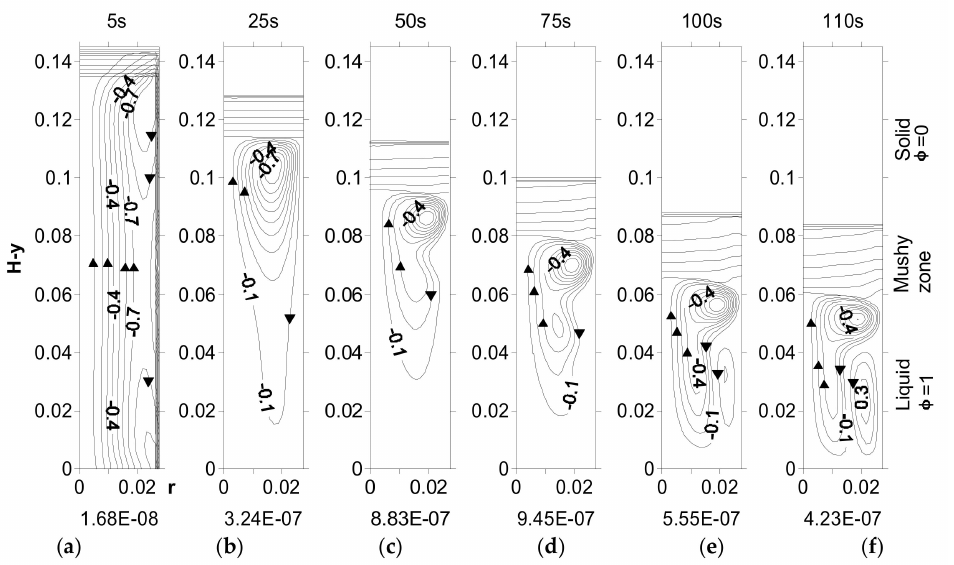
Figure 12. Development of contours of normalized stream function during solidification simulation S6 with effect of undercooling for t = ( a ) 5 s; ( b ) 25 s; ( c ) 50 s; ( d ) 75 s; ( e ) 100 s and ( f ) 110 s. The maximum magnitudes of stream function (m 3 .s − 1 ) are presented at the bottom of ( a – f